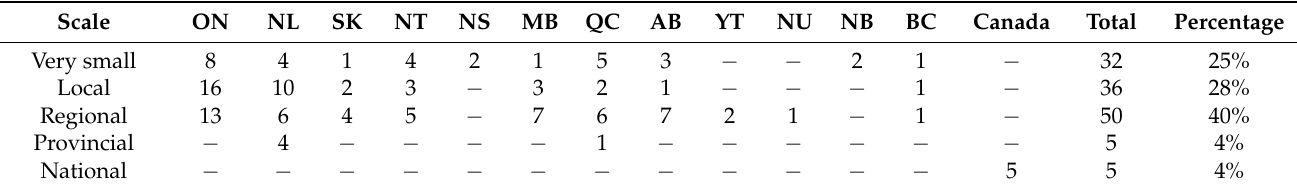
Table 5. The number of publications focusing on various scales of the study area (small, local, regional, provincial, and national) in each Canadian